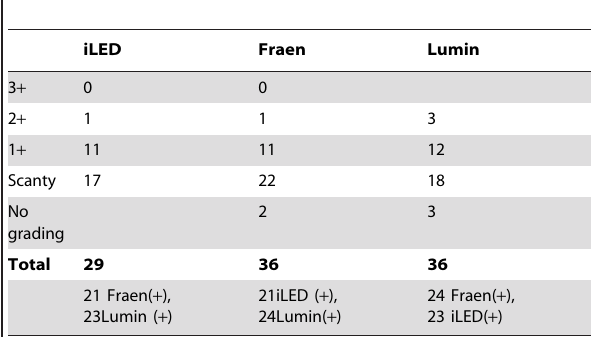
Table 4. False positive